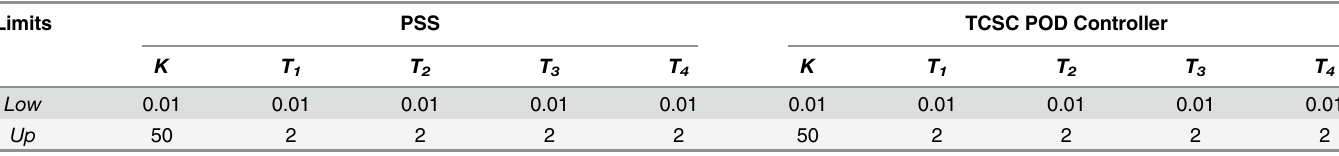
Table 1. Optimization parameter